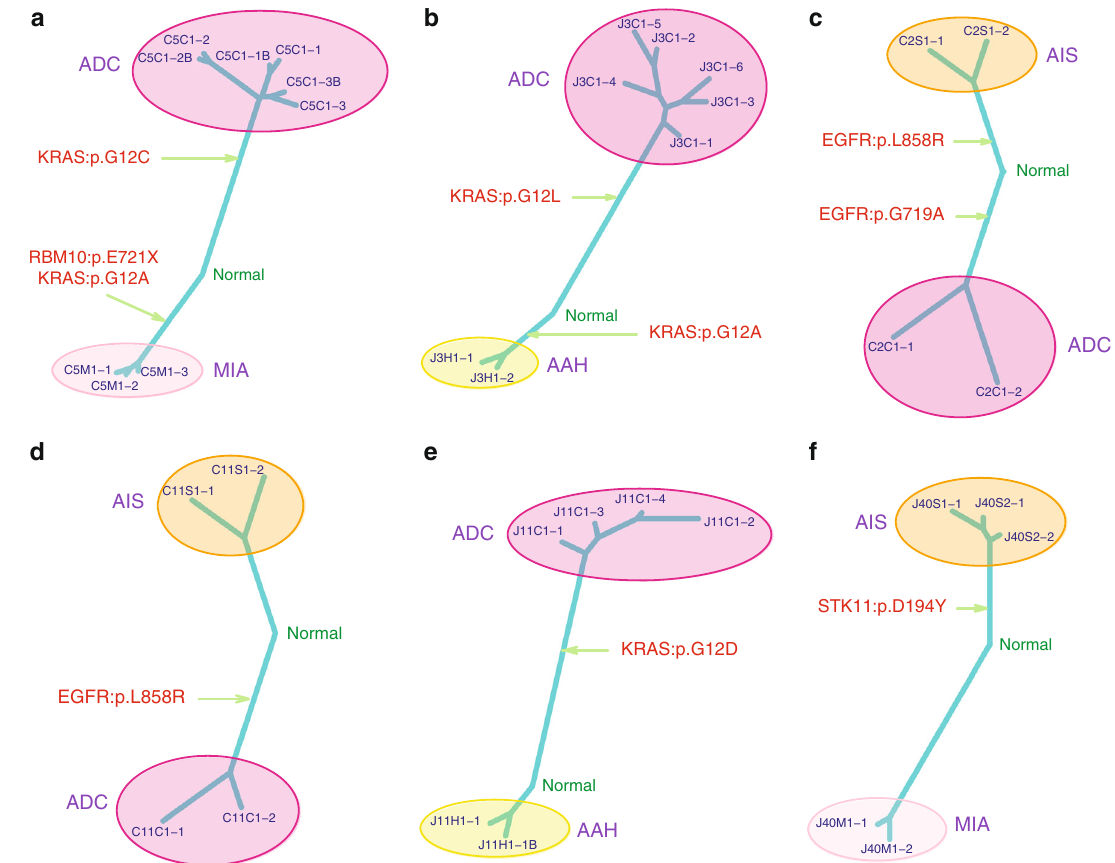
Fig. 5 Representative phylogenetic trees of multifocal IPNs. a – f Phylogenetic trees were generated from all SNVs by using the Wagner parsimony method in “ phangorn ” package. Known cancer gene mutations are mapped to the trunks and branches as indicated. Trunk and branch lengths are proportional to the numbers of mutations acquired on the corresponding trunks or